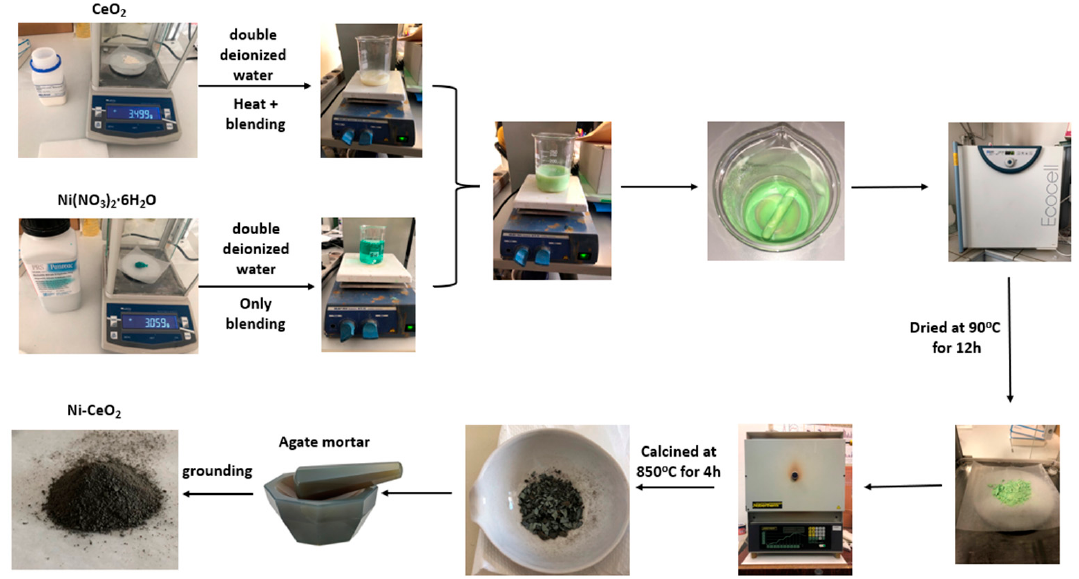
Figure 8. Illustrated procedure for the synthesis of the 15 wt.% Ni/CeO 2